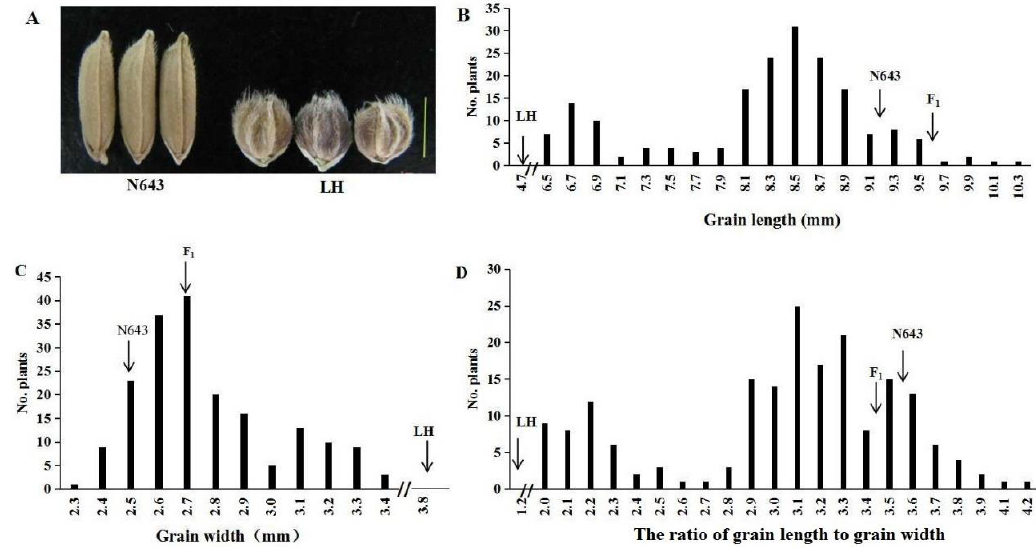
Figure 2. Grain shape characteristics of parents and frequency distribution of grain shape in the RHL2401 population. ( A ) Grain morphology of Longliheinuo-dwarf (LH), N643. Scale bar = 4 mm. Frequency distribution of grain length ( B ), grain width ( C ), and the ratio of grain length to grain width ( D ) in the RHL2401 population.